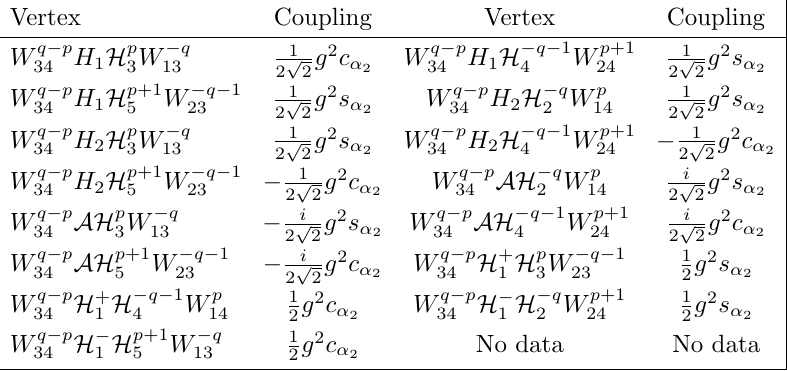
Table 14 . The interactions of two charged gauge bosons with two scalars (Continued).